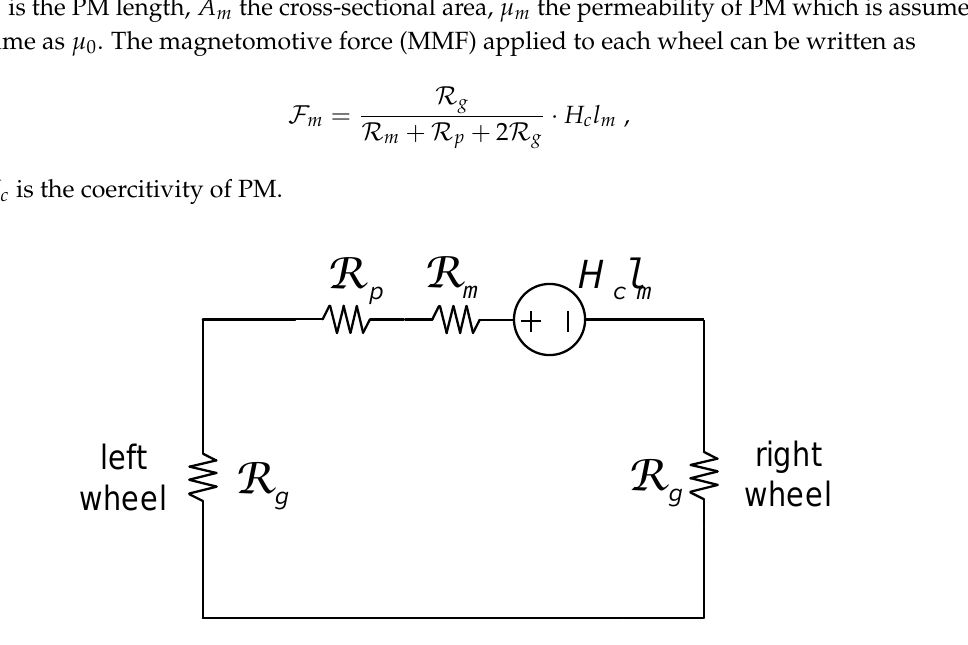
Figure 4. Circuit representation of the magnetic